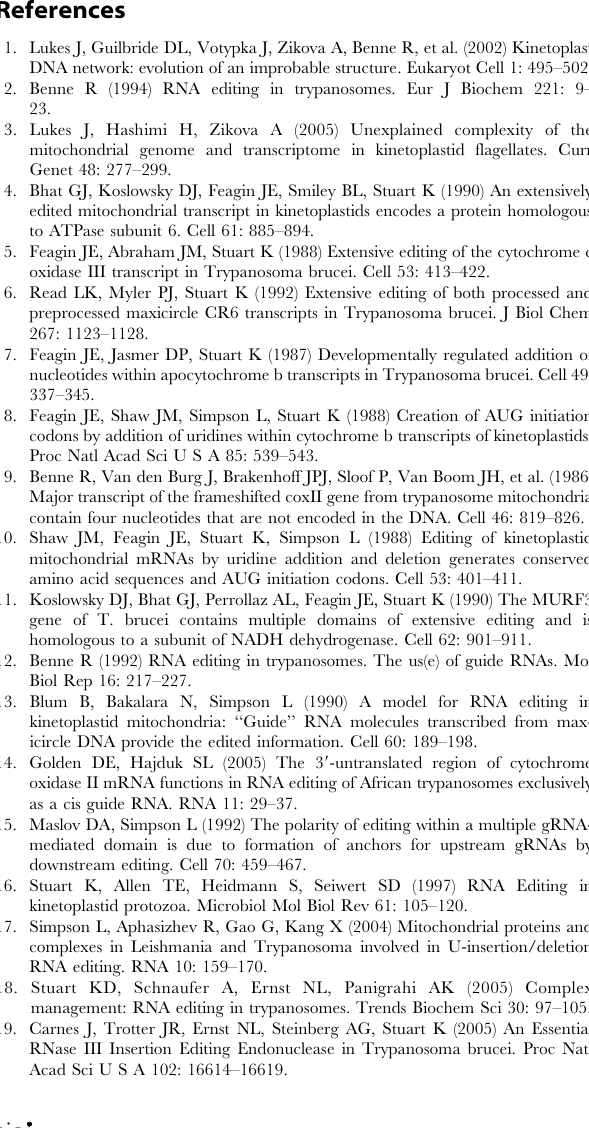
Figure S2 Sequence and location of gMURF2-I and gMURF2- II genes in T. brucei . (A) Editing of MURF2 mRNA is mediated by two gRNAs. (B) Both gMURF2-I and gMURF2-II are transcribed from maxicircle (18, 62). Figure S3 TAP-tagged KREPA3 ZF mutants showed the